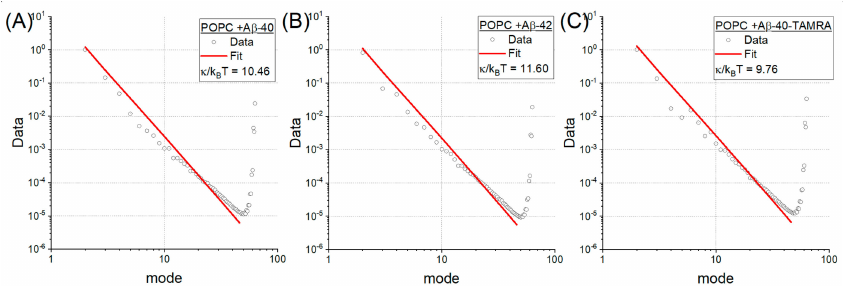
Figure 3. Power spectra along with model fits of investigated Molecular Dynamics systems with ( A ) A β -40, ( B ) A β -42 and ( C ) A β -40-TAMRA monomers, which were used for κ (bending rigidity)